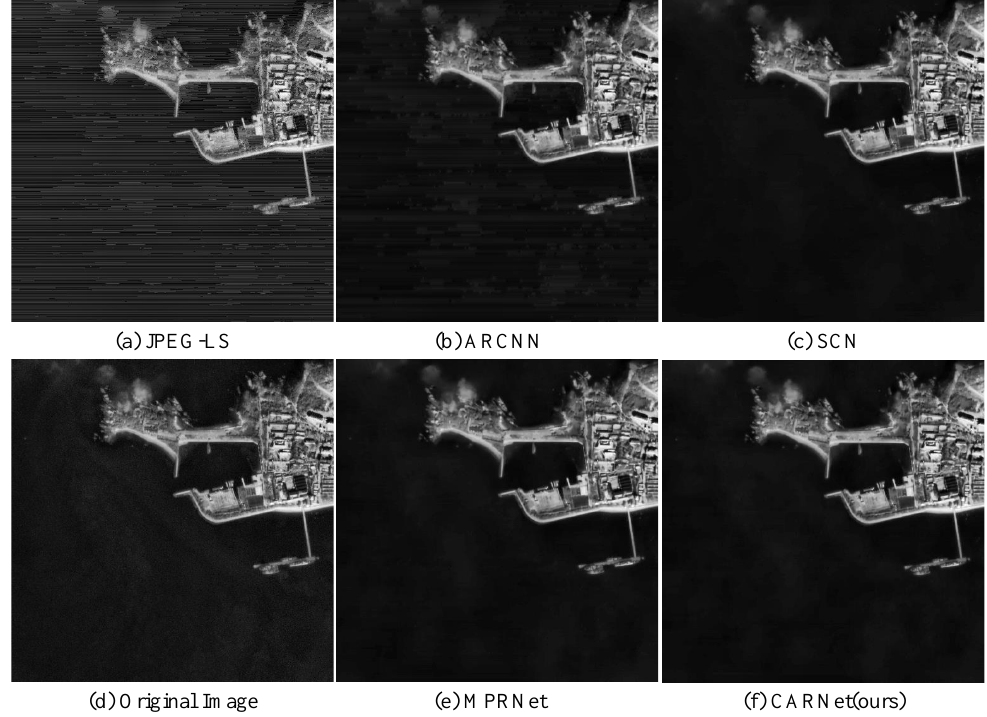
Figure 11. Visual comparison with state-of-the-art methods on a test 10-bit image patch (NEAR =